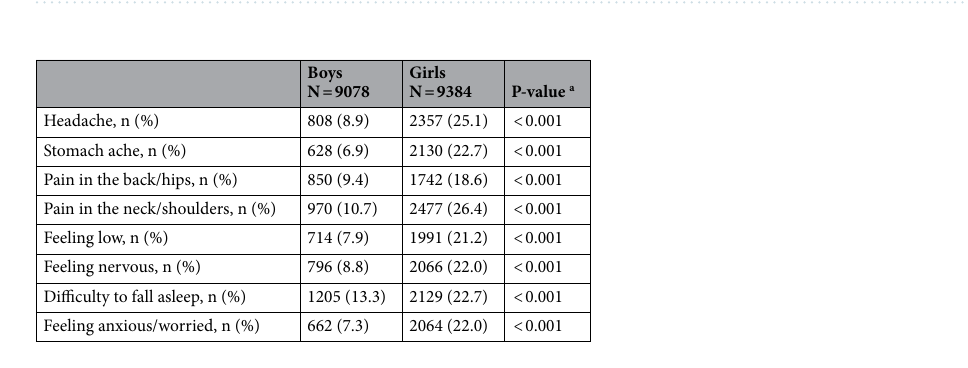
Table 2. Proportion of self-reported psychosomatic complaints (PSC) experienced often or always among boys and girls. a Chi-square